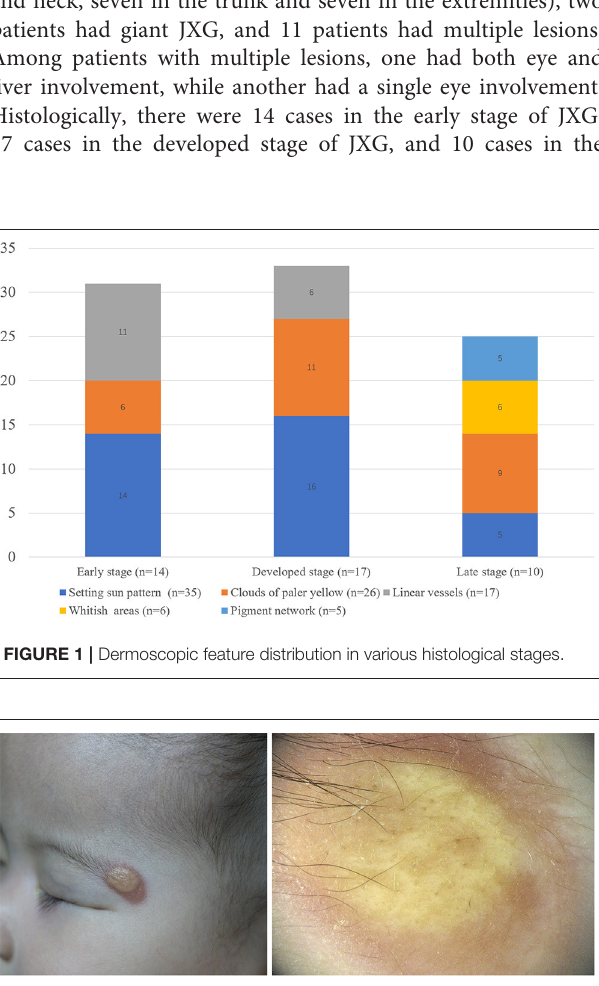
FIGURE 2 | Setting sun pattern (Right) and its clinical appearance (Left) .